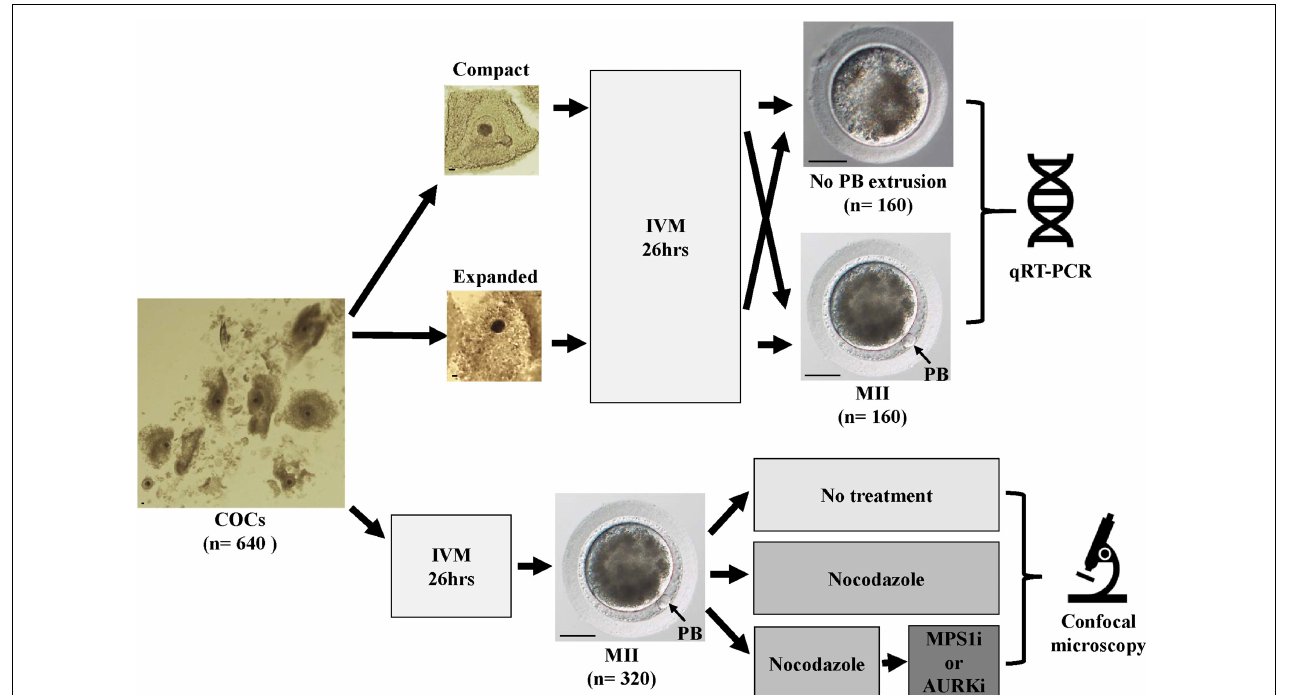
FIGURE 1 | Schematic representation of the study design. Scale bars, 40 µ